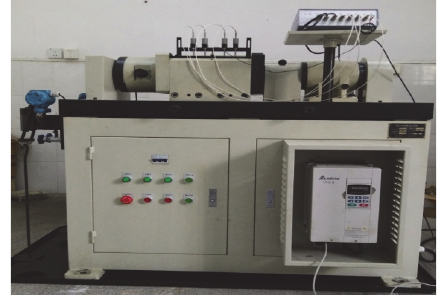
Figure 6: Vibration wave under the normal condition.